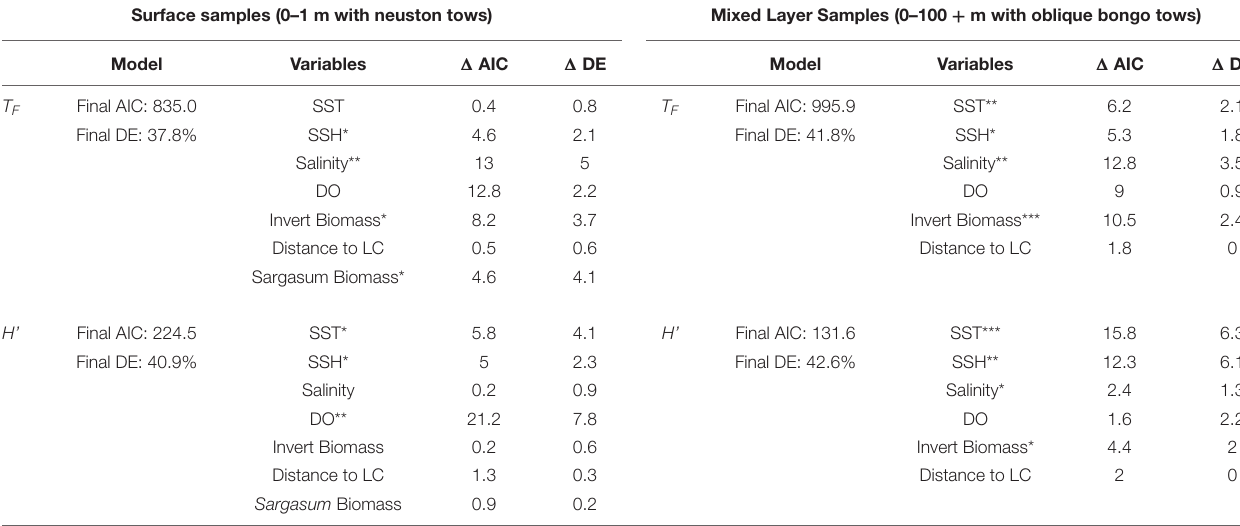
TABLE 3 | Akaike information criterion (AIC), deviance explained (DE), and variables retained in the final GAMs based on taxonomic richness ( T F ), and Shannon diversity ( H’ ) for surface samples (0–1 m with neuston tows), and mixed layer samples (0–100 + m with oblique bongo tows) collected in 2015 and 2016. Surface samples (0–1 m with neuston tows) Mixed Layer Samples (0–100 + m with oblique bongo